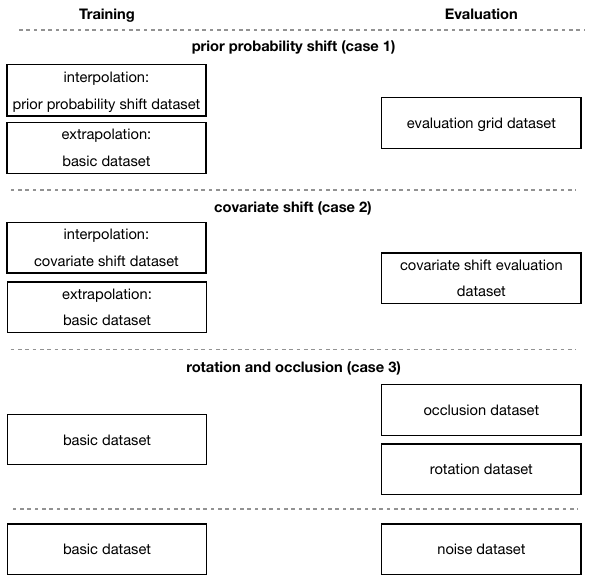
Figure 1. Evaluation strategy. We define three different evaluation scenarios for epistemic uncertainty estimation: Case 1 refers to a dataset shift only of the target square center positions, case 2 considers a dataset shift of the gray value distribution of the input data, and case 3 evaluates the epistemic uncertainty estimation in case of rotated and occluded squares in the evaluation images. The aleatoric uncertainty estimation is evaluated by increasing the input data noise in the evaluation